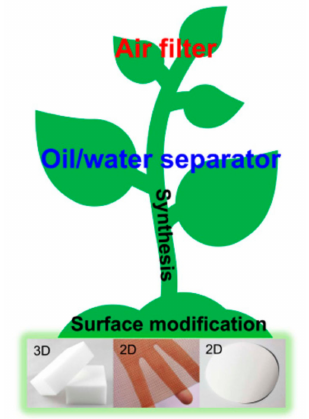
Figure 1. Schematic illustration for 2D and 3D bulk material-based environmental remediation.